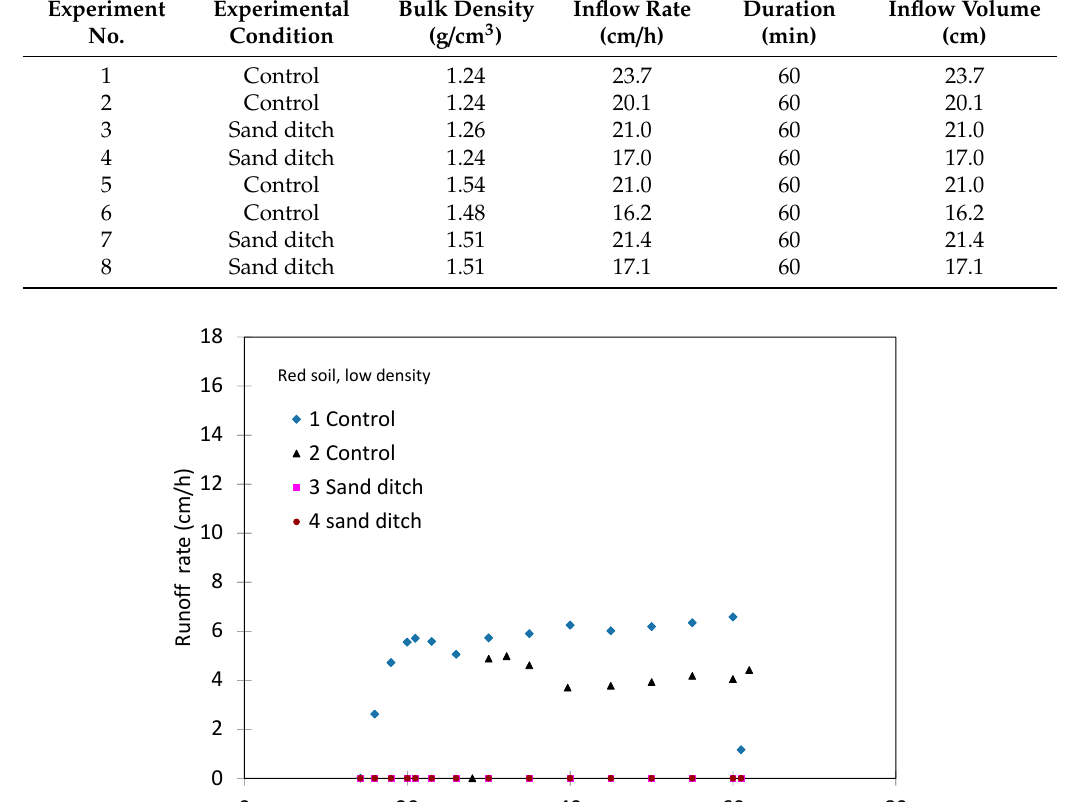
Table 2. Summary of the runoff experimental conditions conducted in soil box.